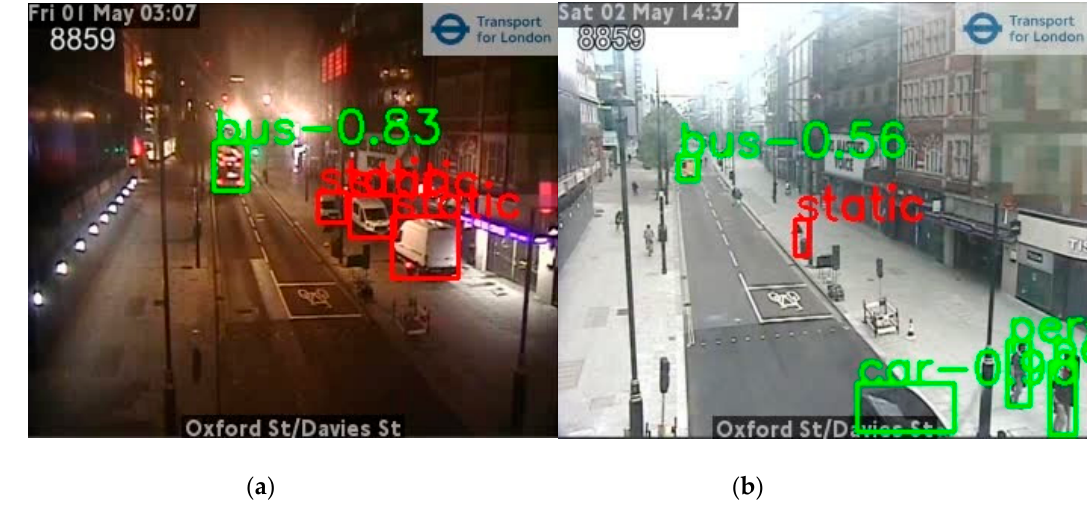
Figure 15. Examples of annotation results where a static mask has been applied in post-processing. ( a , b ) were taken from a camera from Oxford Street, London at different time where green boxes are moving objects and red boxes are static objects (images supplied by TfL Open Data).